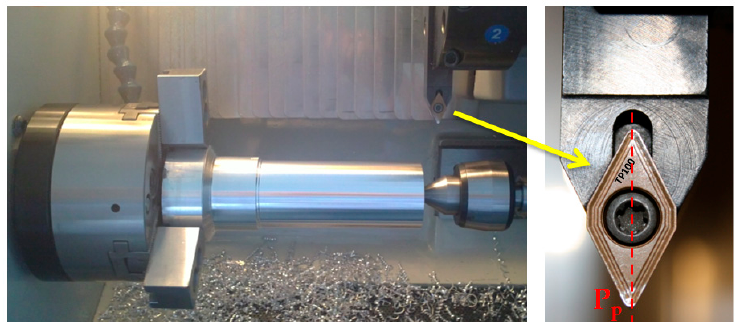
Figure 1. Turning test setup.